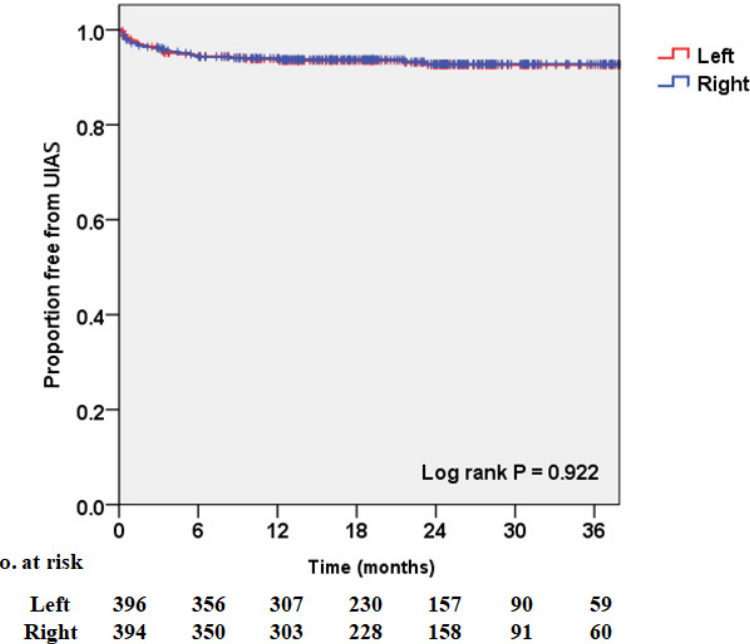
Figure 2. Kaplan–Meier curve showing the uretero-intestinal anastomosis stricture-free rate after radical cystectomy with ileal orthotopic neobladder according to laterality.